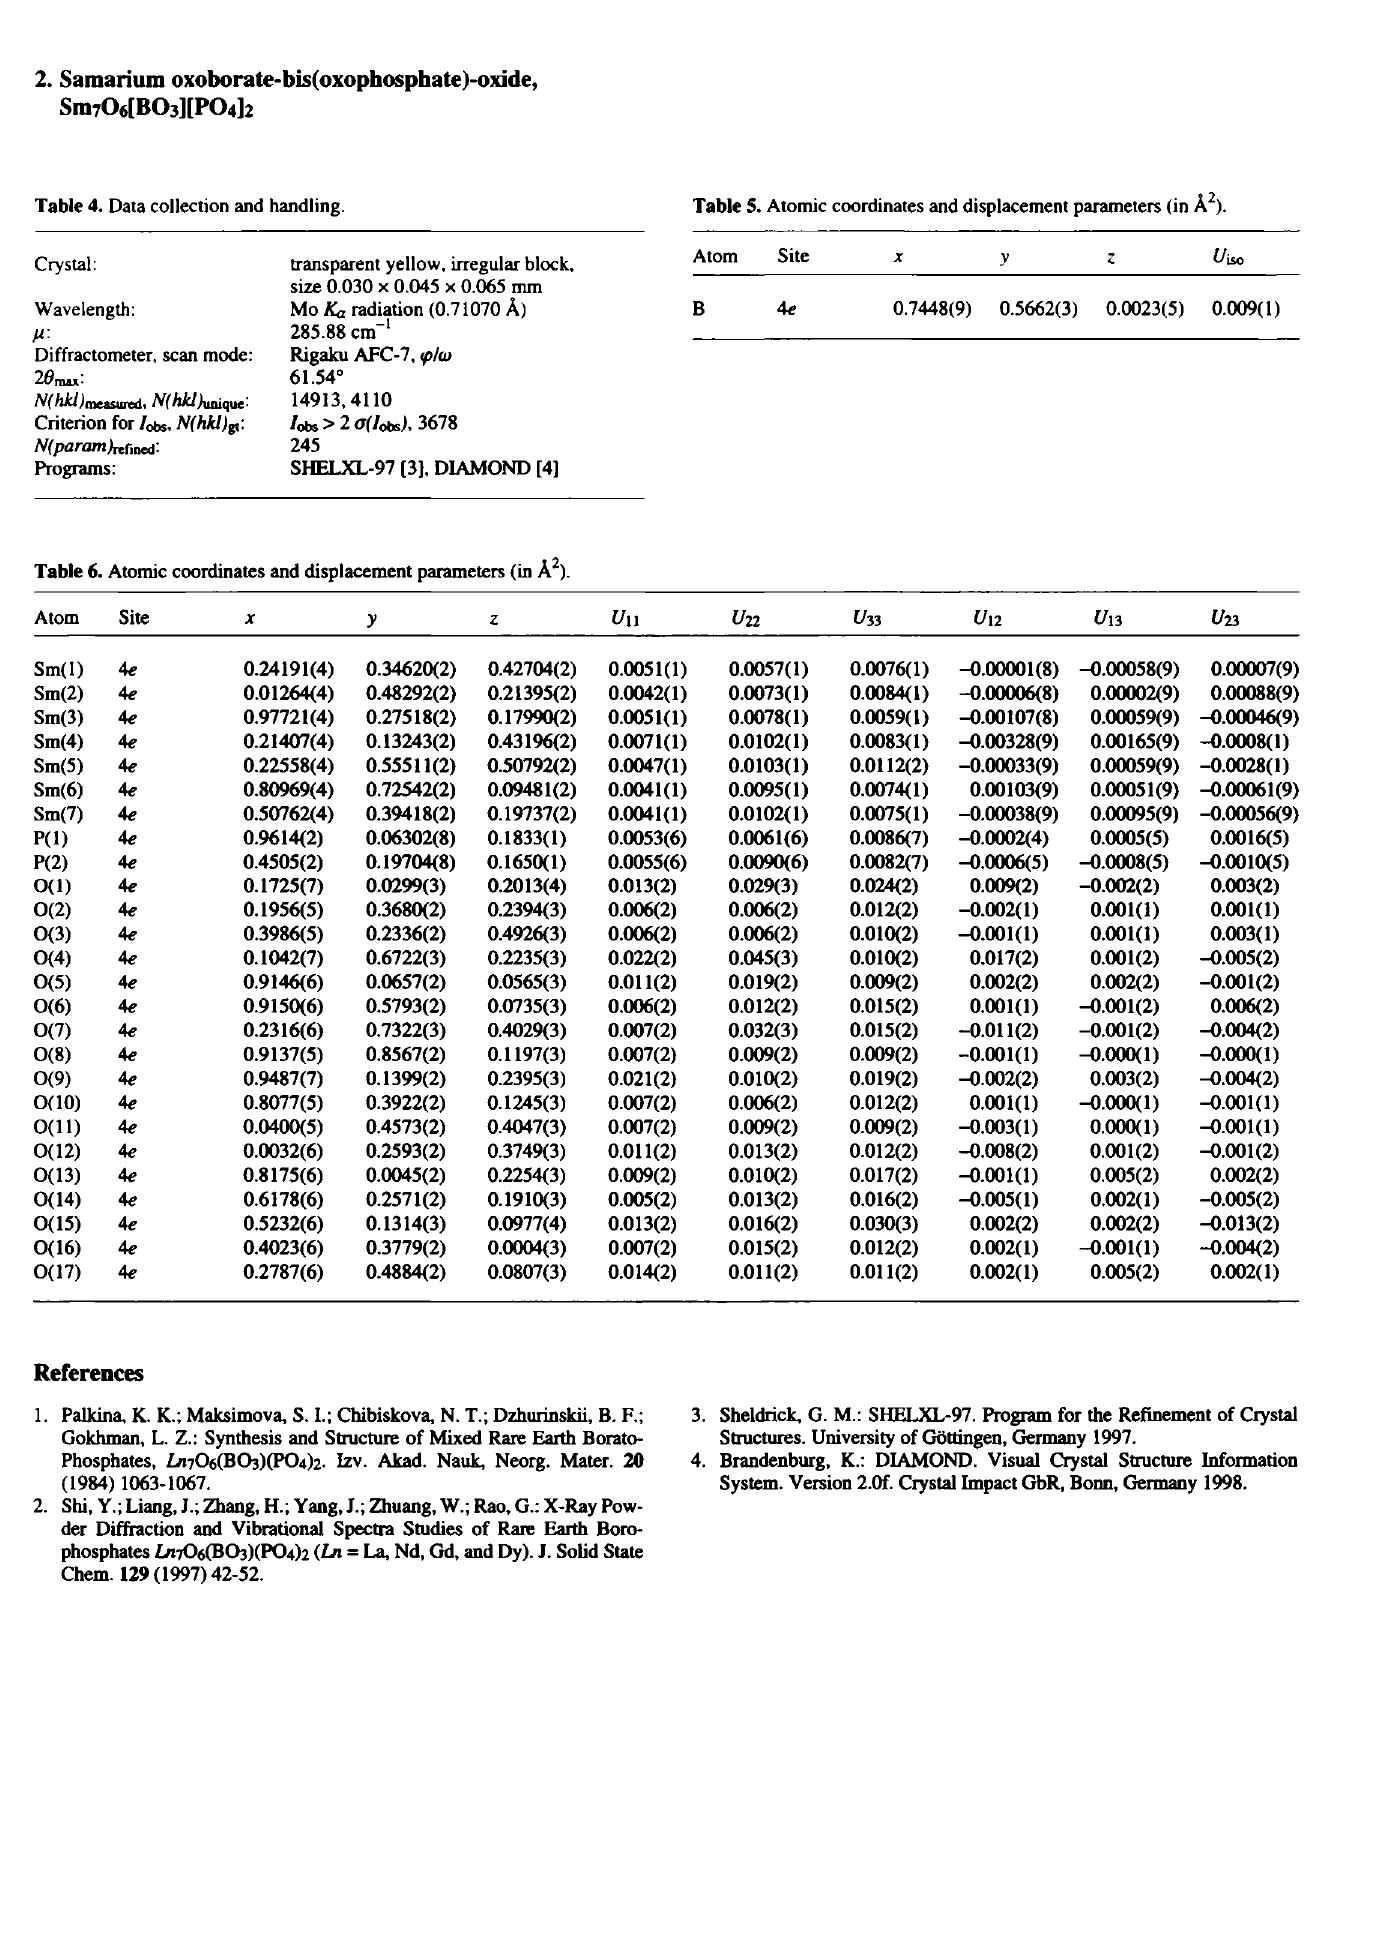
Table 6. Atomic coordinates and displacement parameters (in Â 2